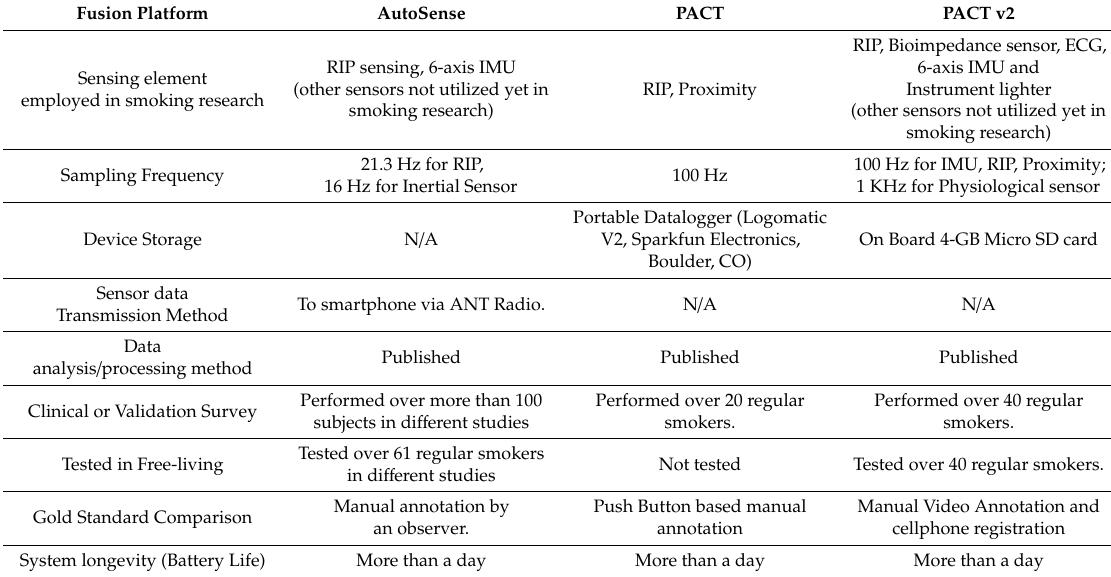
Table 13. The comparison of multi-sensor approaches on a fusion